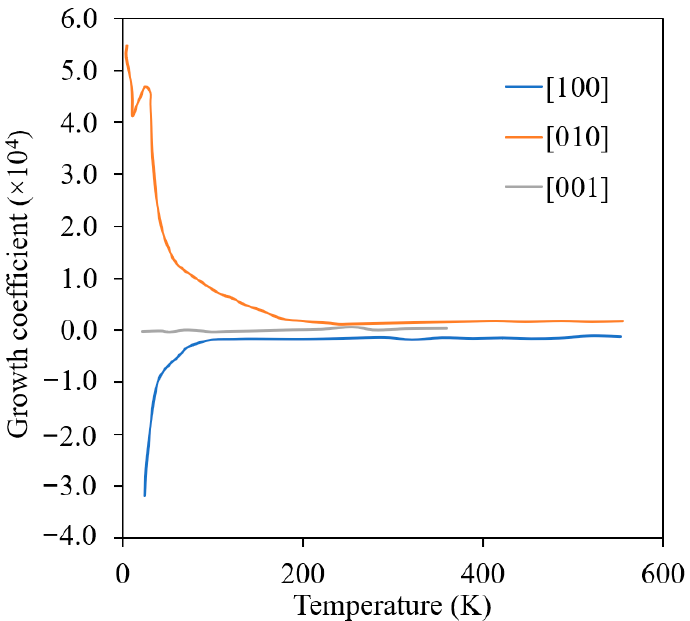
Figure 6. Effect of irradiation temperature on the growth coefficient of α -U single crystals (Reprinted/adapted with permission from Ref. [42], 2022, Taylor & Francis).